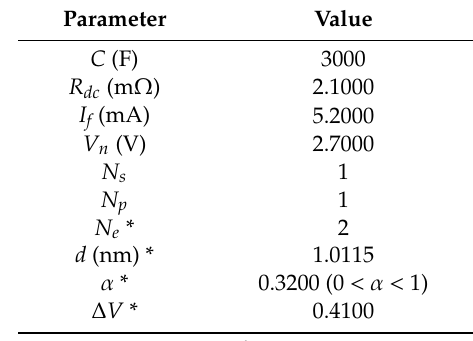
Table A1. Stern-Tafel Model Parameters with current profile i 1 .